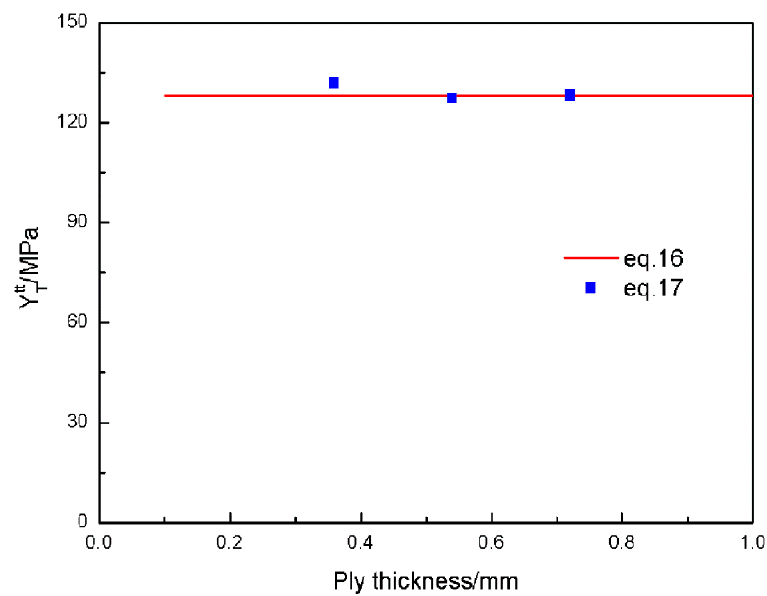
Figure 13. The relationship between the transverse ply strength and transverse ply thickness.